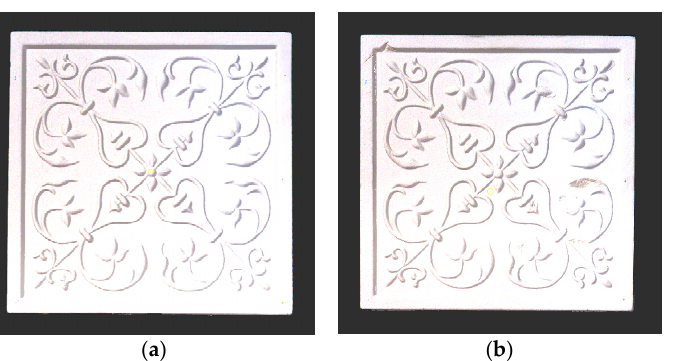
Figure 12. Three-dimensional models of the original surface ( a ) and changed surface ( b ) of Case Study I. Table 7. Correctness of the ground truth table with Nonchanged Threshold.